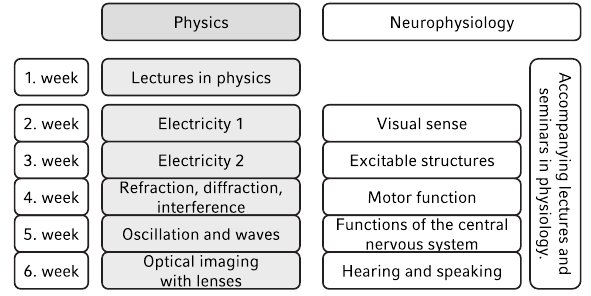
FIG. 3. Schedule for the first part of the